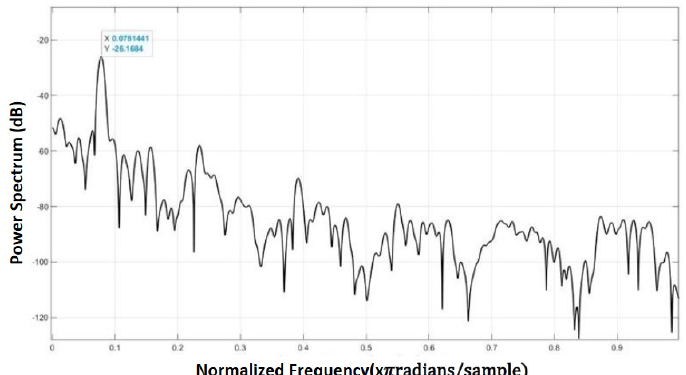
Figure 9. Power spectrum computed from a smoothed sensor signal window.